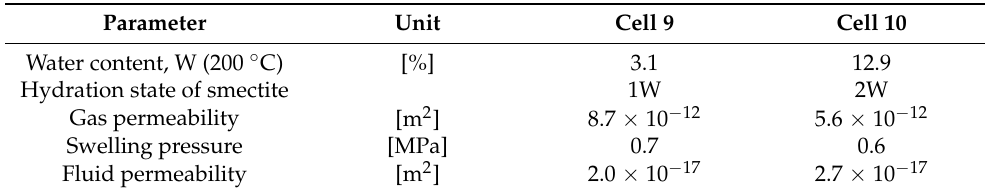
Table 4. Water content of DS, hydration state of smectite and gas permeability during installation and final swelling pressure and fluid permeability of cell 9 and cell